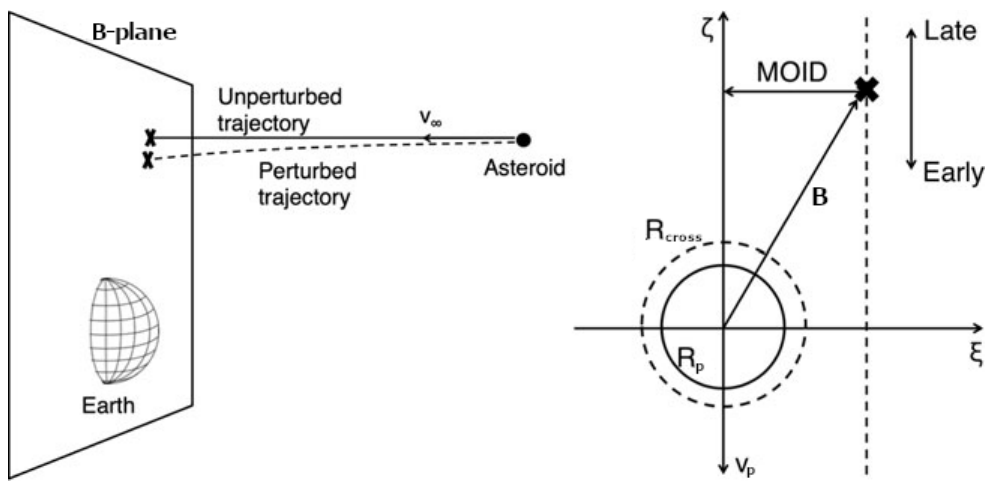
Figure 2. Left: B-plane with respect to the asteroid’s trajectory relative to the Earth. Right: B-plane coordinates and interpretation. Figure adapted from Figure 1 in